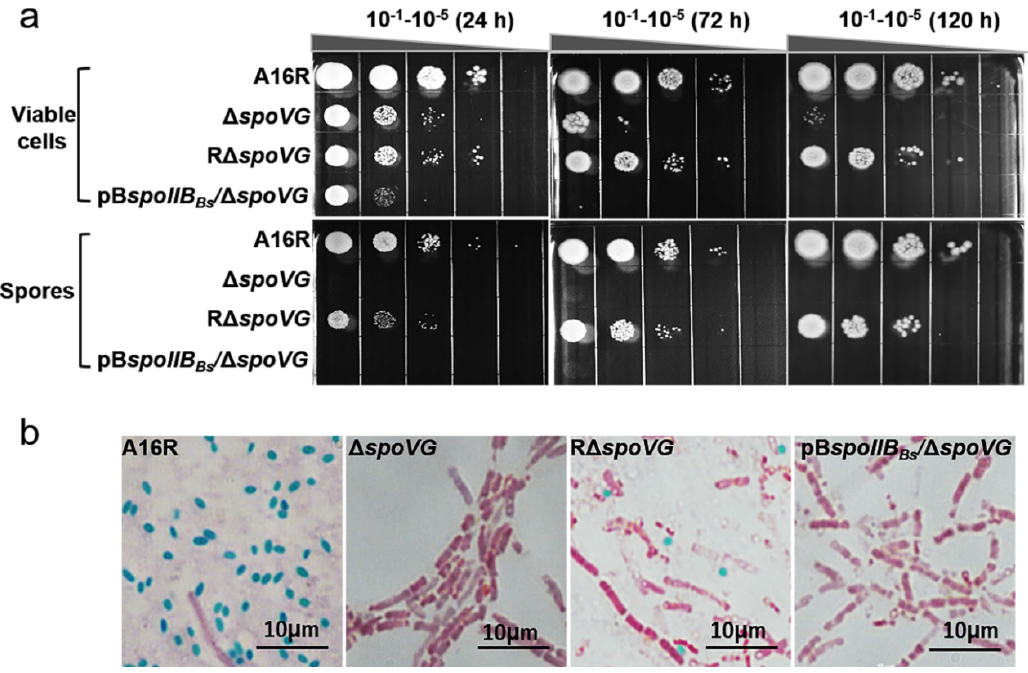
Figure 5. Sporulation of the B. anthracis pB spoIIB Bs /Δ spoVG strain. ( a ) Strains were cultured in DSM for 24, 72, and 120 h. The cultures were serially diluted and 10 μL aliquots of each dilution (10 −1 through 10 −5 ) were plated on LB-agar. After heat inactivation, spores were diluted and plated in the same manner. Images of plates after overnight incubation at 37 °C are shown. The Δ spoVG and pB spoIIB Bs /Δ spoVG strains did not form heat-resistant spores. ( b ) Cultures of four strains were stained with malachite green and safranin O at 120 h. Spores and vegetative cells were stained green and red, respectively. Scale bar, 10 μm.